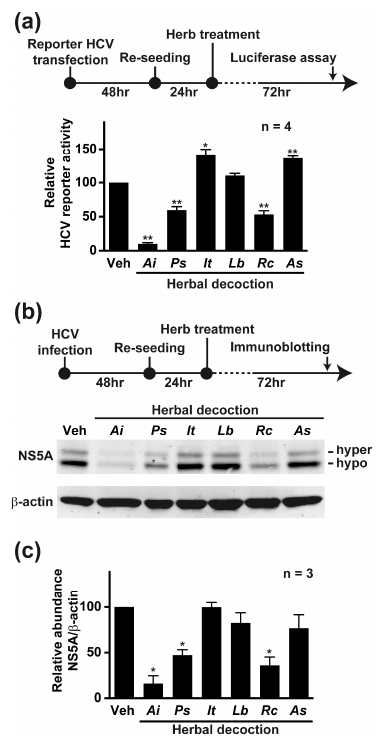
Figure 2. Aeginetia indica decoction reduced the HCV reporter activity and the HCV non-structural protein 5A (NS5A) protein level. ( a ) Effects of six herbal decoctions on the HCV reporter activity in Huh7.5.1 cells transfected with a full-length HCV genomic RNA containing a luciferase reporter (5 ′ C19Rluc2aUbi, strain 2a). Concentrations of the herbal decoctions were (in mg/mL): Aeginetia indica (Ai) 8, Paeonia suffruticosa (Ps) 1, Isatis tinctoria (It) 10, Lycium barbarum (Lb) 10, Radix curcumae (Rc) 10, and Angelica sinensis (As) 10. Values are mean ± SEM summarized from four independent experiments. One and two asterisks indicate statistical significance at p < 0.05 and p < 0.01 based on t-test against values under the vehicle (Veh) control; ( b ) Representative and ( c ) summary of immunoblotting for HCV NS5A protein in Huh7.5.1 cells infected with HCV (J6/JFH1, genotype 2a). Hyper and hypo represent hyper- and hypo-phosphorylated NS5A, respectively.